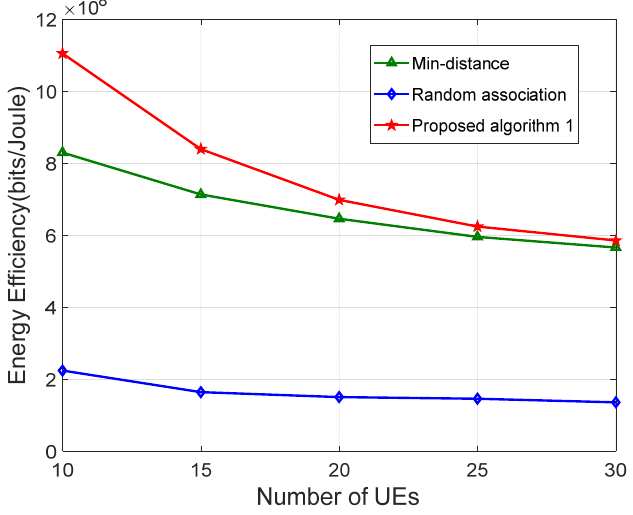
Figure 3. Energy efficiency versus the number of UEs for different algorithms.